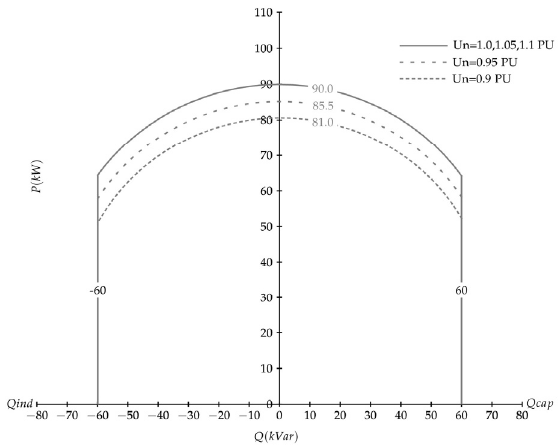
Figure 10. P ‐ Q diagram of the inverter. Figure 10. P-Q diagram of the